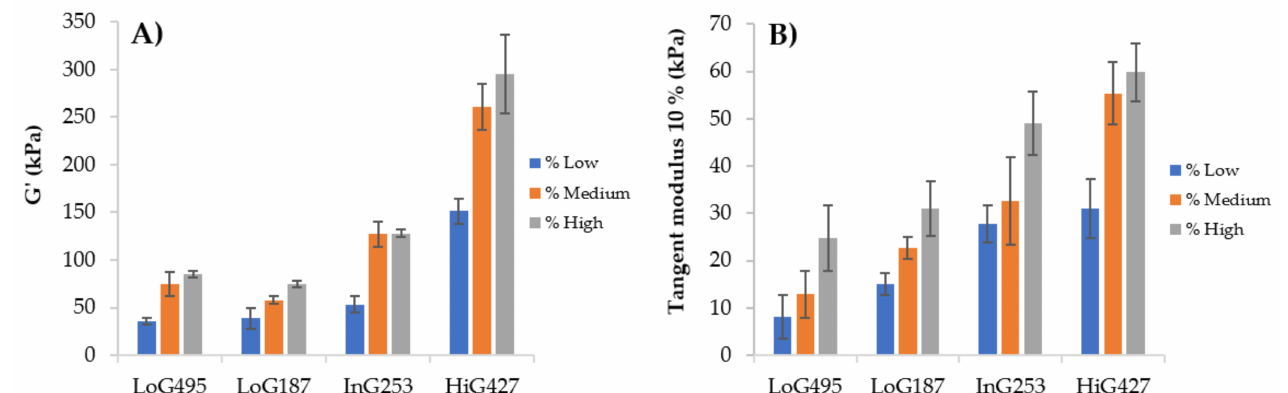
Figure 5. Values of the ( A ) storage modulus G’ and ( B ) tangent modulus at 10% of strain for each alginate gel at different alginate concentrations and 100 mM of CaCl 2 at 23 ◦